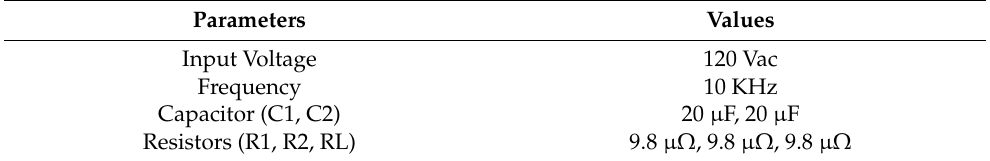
Table 2. Armatures for equivalent circuit.